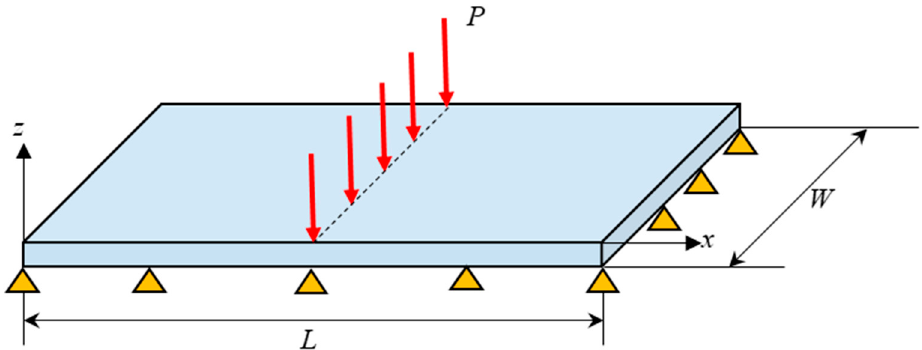
Figure 4. Simply supported functionally graded Mindlin plate.